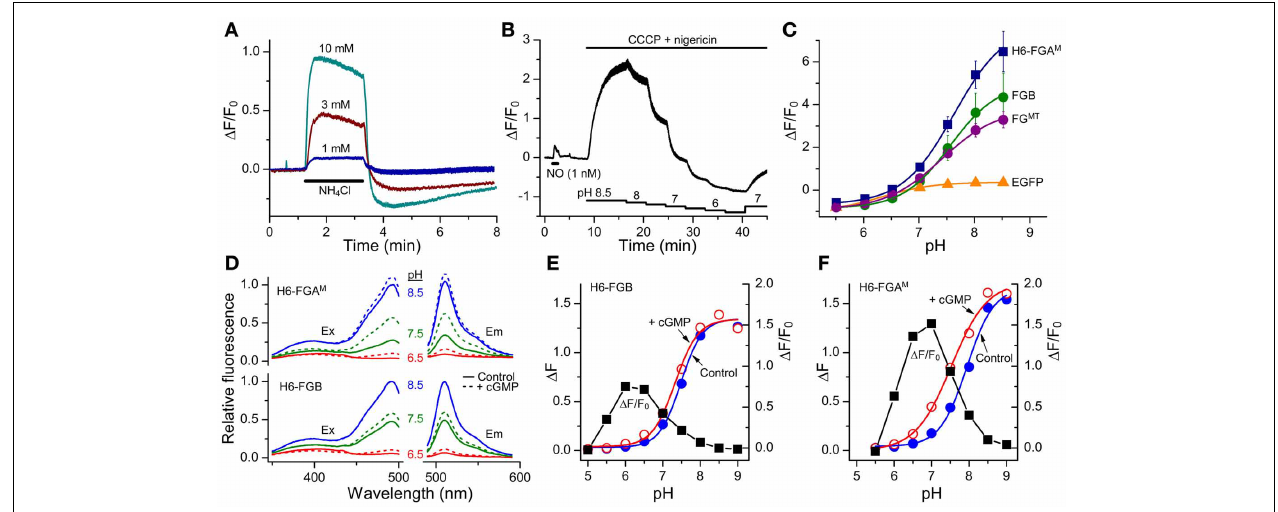
FIGURE 5 | Sensitivity of FlincG variants to pH. (A) Responses of HEK GC / PDE5 cells expressing FGB to 2-min applications of NH 4 Cl (horizontal bar). Traces are means from 40 cells; vertical bars are ± SEM. (B) HEK GC / PDE5 cells expressing FGB were initially stimulated with NO (1nM; 1min), after which the combination of CCCP (20 μ M) and nigericin (10 μ M), which results in an equalization of intracellular and extracellular pH, was superfused at different pH values (as indicated by the stepped horizontal bars below). The trace is the average of 10 cells; vertical bars are ± SEM. (C) Summary pH titration data obtained as in panel (B) on